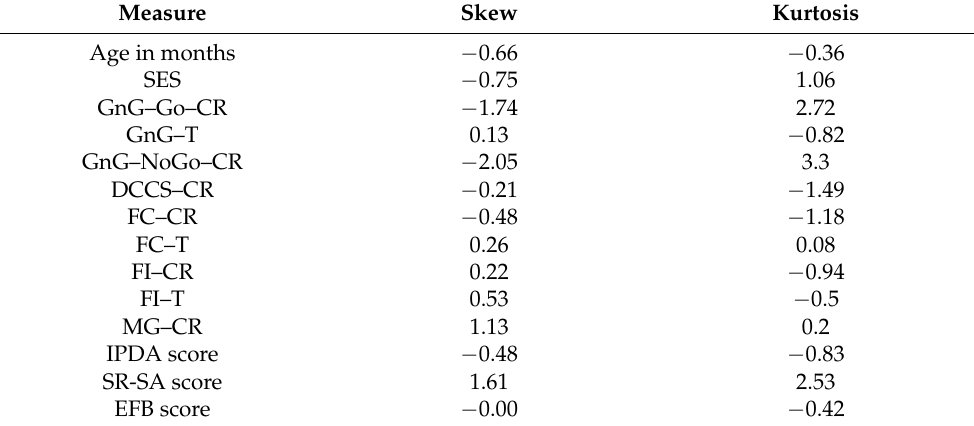
Table 2. Skew and kurtosis of the scores distributions for age, socio-economic status, the EF tests, the learning prerequisites, the behavioral questionnaires and scales.